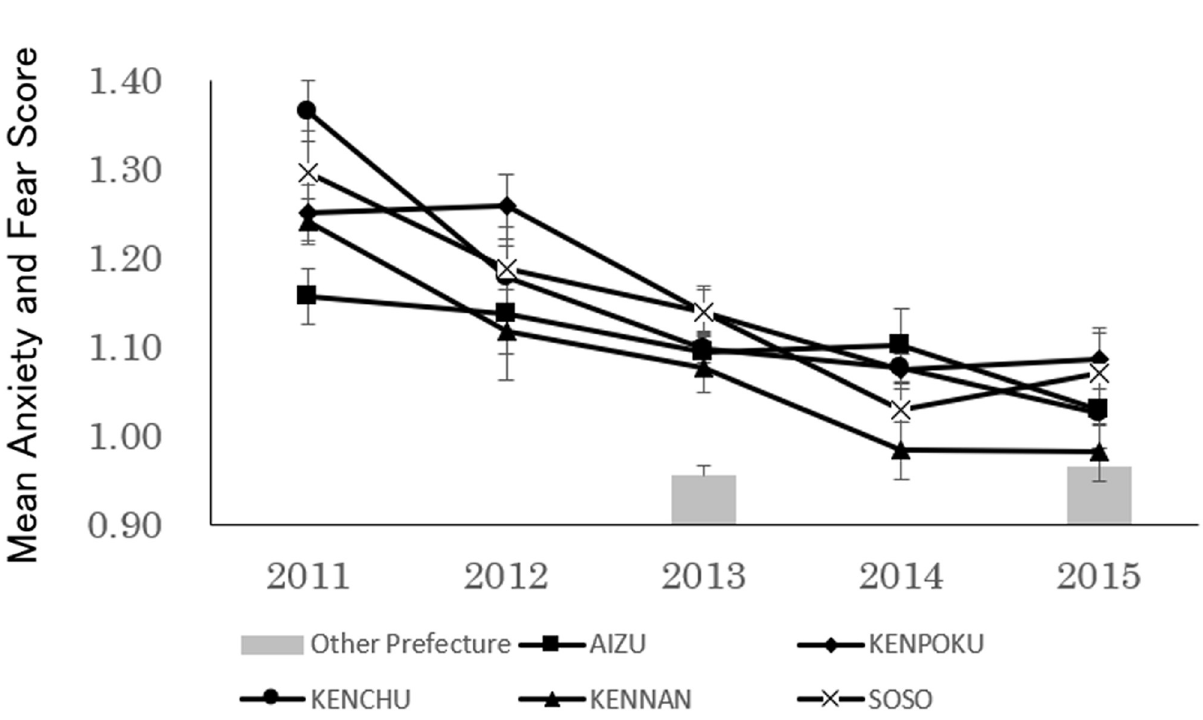
Fig 5. Transition over time in anxiety and fear (Mean ± SE) of 18 and 42-month-old children in low-contamination regions.